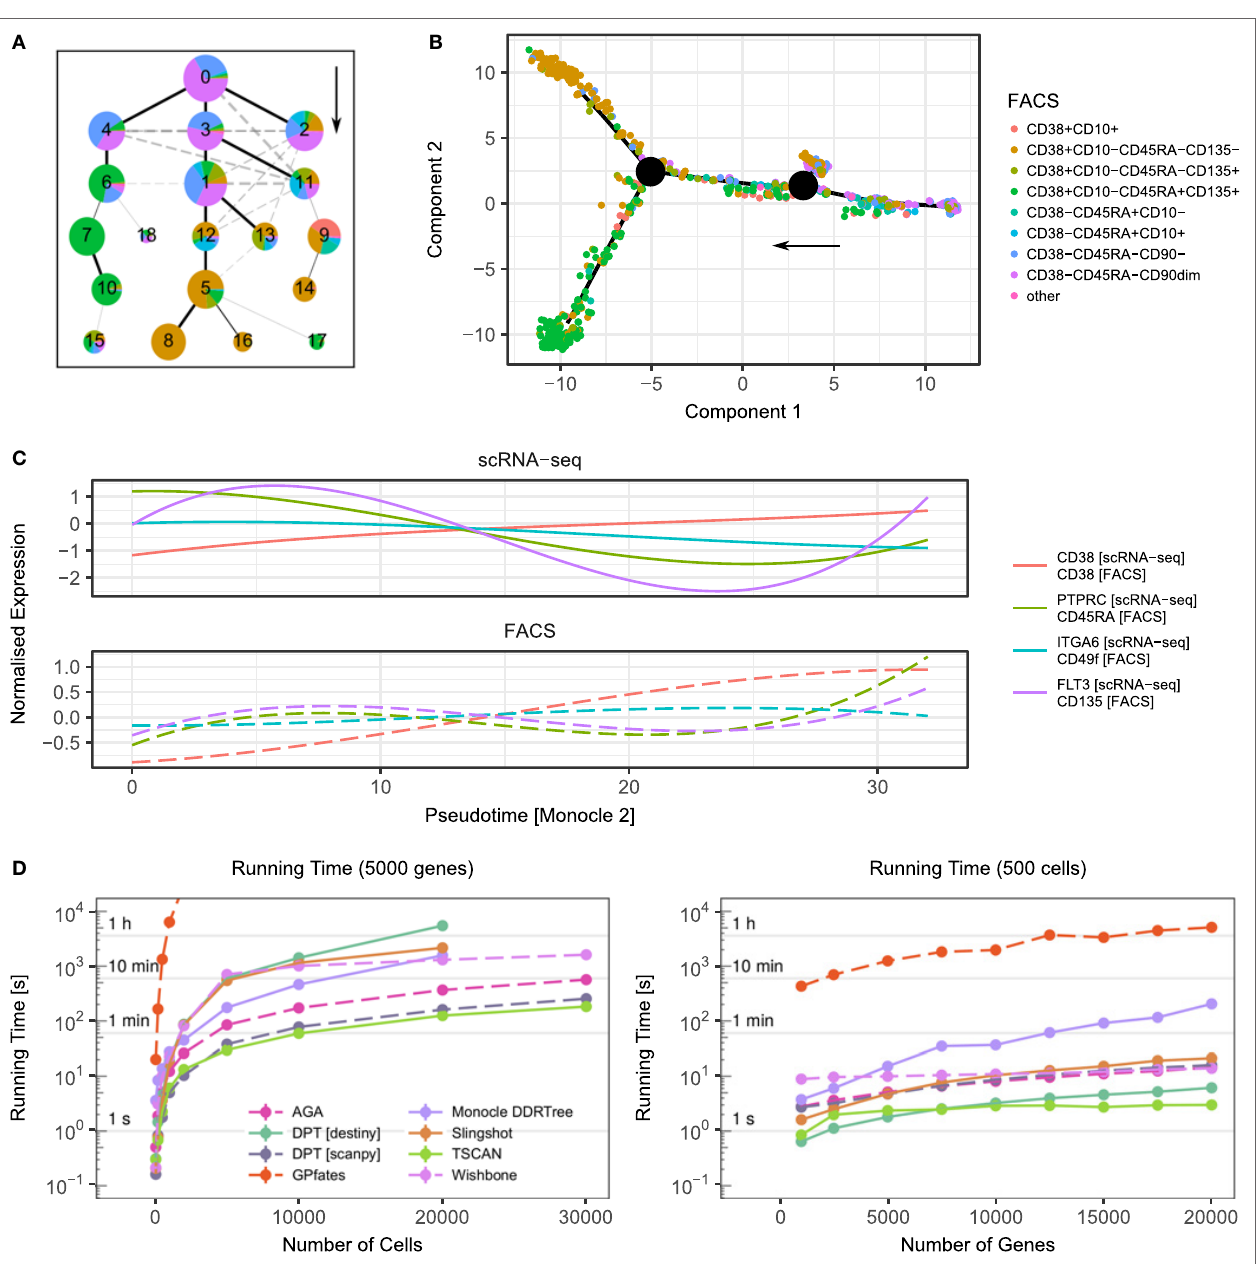
FiGURe 1 | Examples of trajectory inference methods and their performance. (A) Result of approximate graph abstraction (AGA (52)) for a human hematopoiesis dataset by Velten et al. (54). The colours indicate the results from indexed FACS sorting. (B) Monocle 2 DDRTree (45) trajectory branching inference for the same hematopoiesis dataset. (C) scRNA-seq and FACS measurements over pseudotime inferred by Monocle 2. Following the Monocle approach, the expression has been smoothed over pseudotime using splines. (D) Performance of selected trajectory inference methods and their dependence on cell number (left) and gene number (right). For benchmarking, artificial datasets based on data by Velten et al. were created using Splatter (54, 56). Points denote mean and SEM of 10 independent runs. The missing data points result from a computational running time